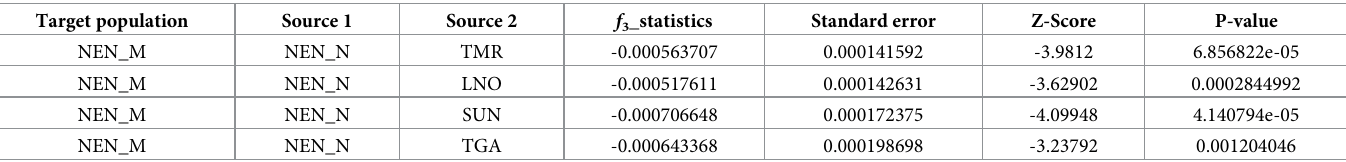
Table 3. Significantly negative Z-scores of the f 3 statistic in 10